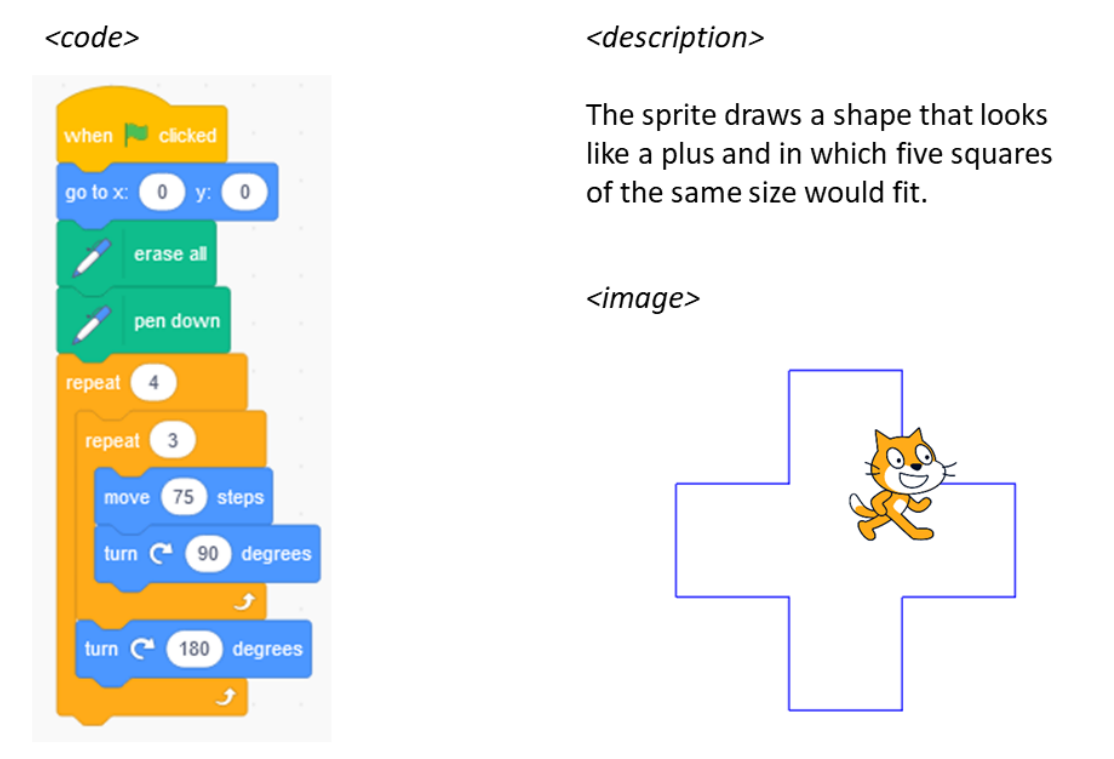
Figure 2. One example for possible